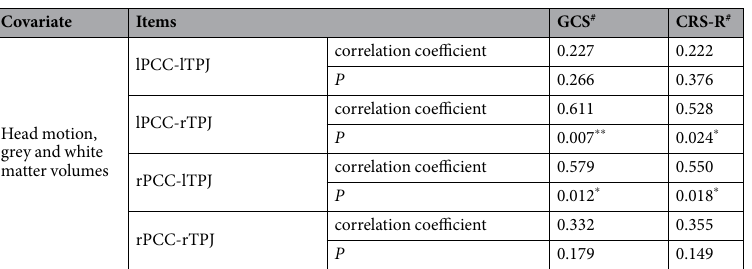
Covariate Items GCS # CRS-R #